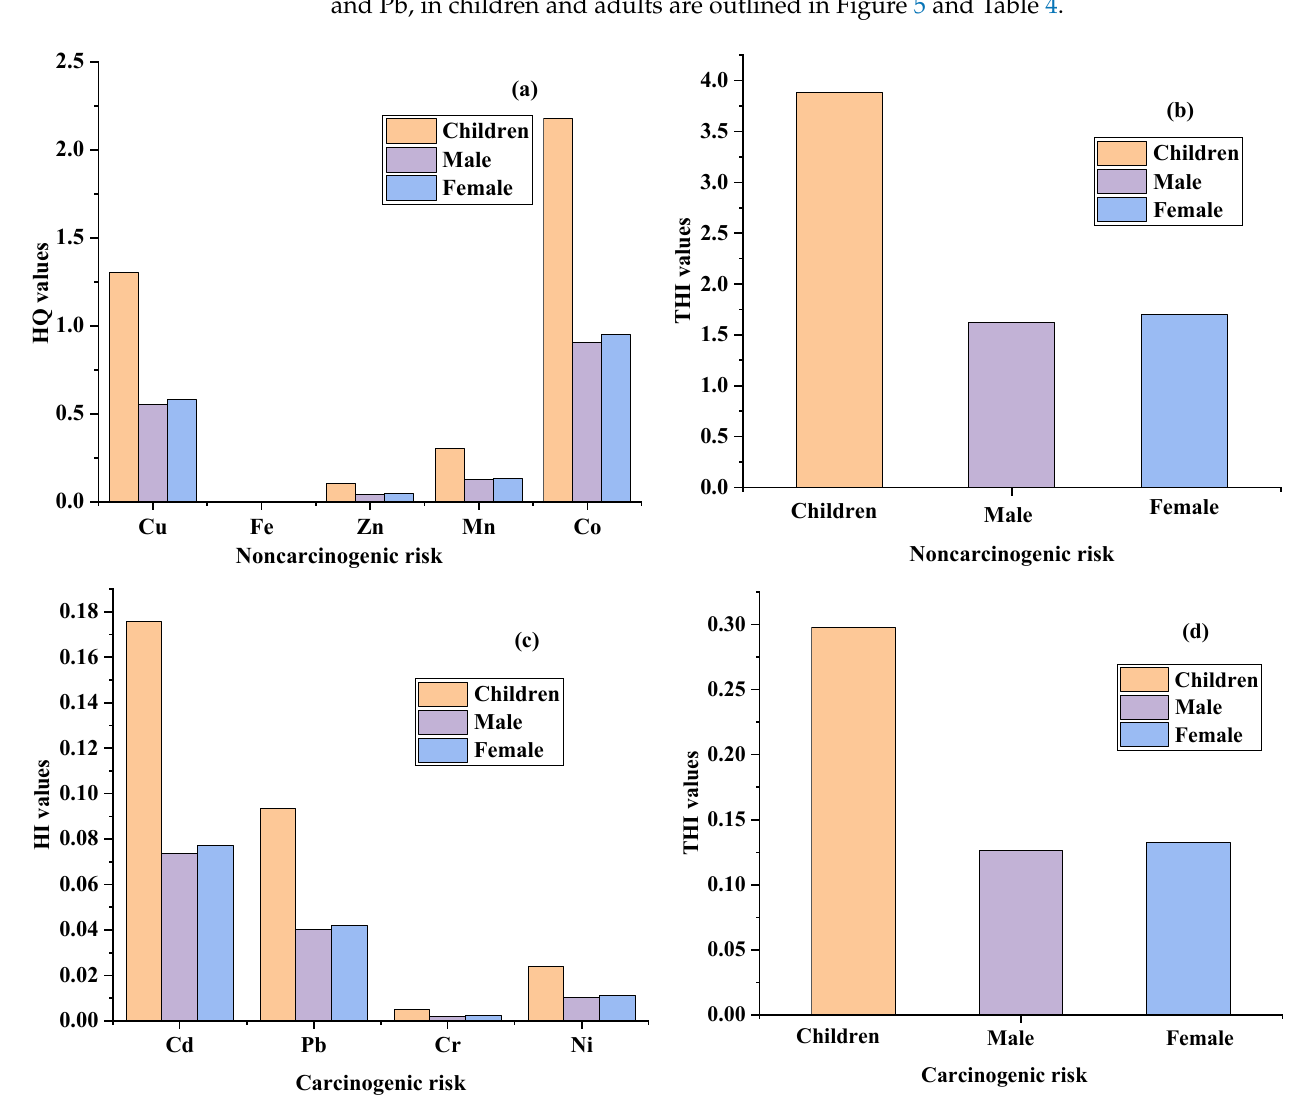
Figure 5. ( a ) Represents HQ values of Cu, Fe, Zn, Mn, and Co for children, male, and female exposed to noncarcinogenic risk, ( b ) THI values of noncarcinogenic risk, ( c ) HI values for Cd, Pb, Cr, and Ni causes carcinogenic risk, and ( d ) THI values of carcinogenic risk in children, male, and female in Adenzai flood plain region of Pakistan. Table 4. Describe the non-cancer risk and the cancer risk of PHE consumption through oral inges- tion of groundwater from the Adenzai flood plain region of Pakistan.